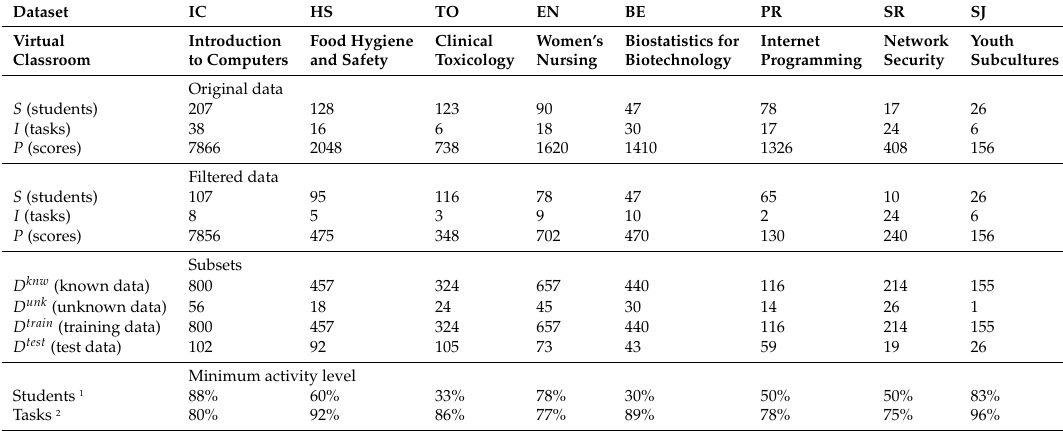
Table 2. Experimental datasets.